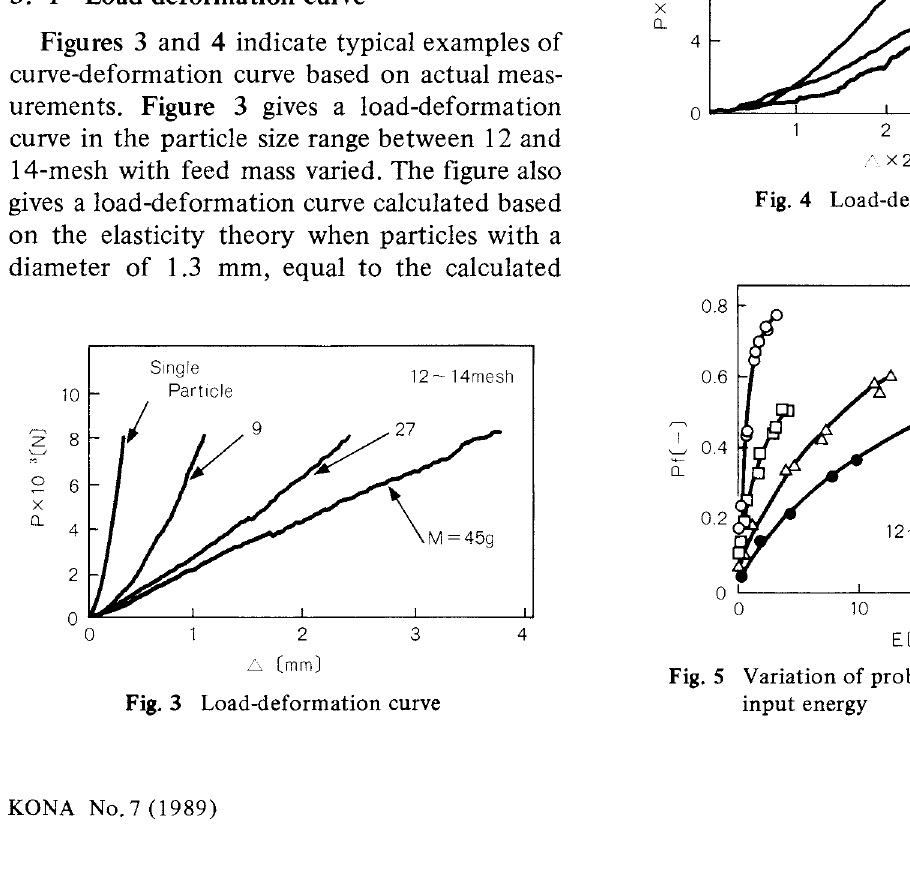
Fig. 3 Load-deformation curve